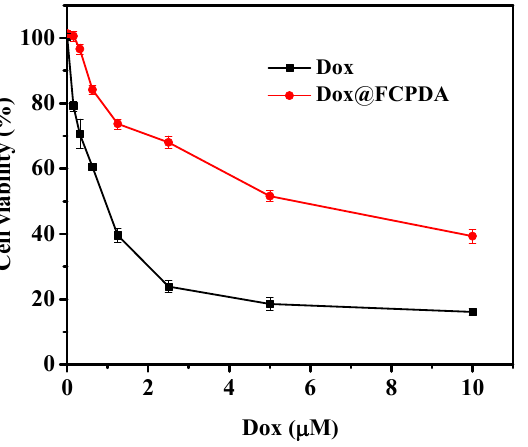
Figure 7. In vitro cytotoxicity of HepG2 cancer cells treated with various concentrations of Dox alone and Dox-loaded FCPDA nanoparticles.